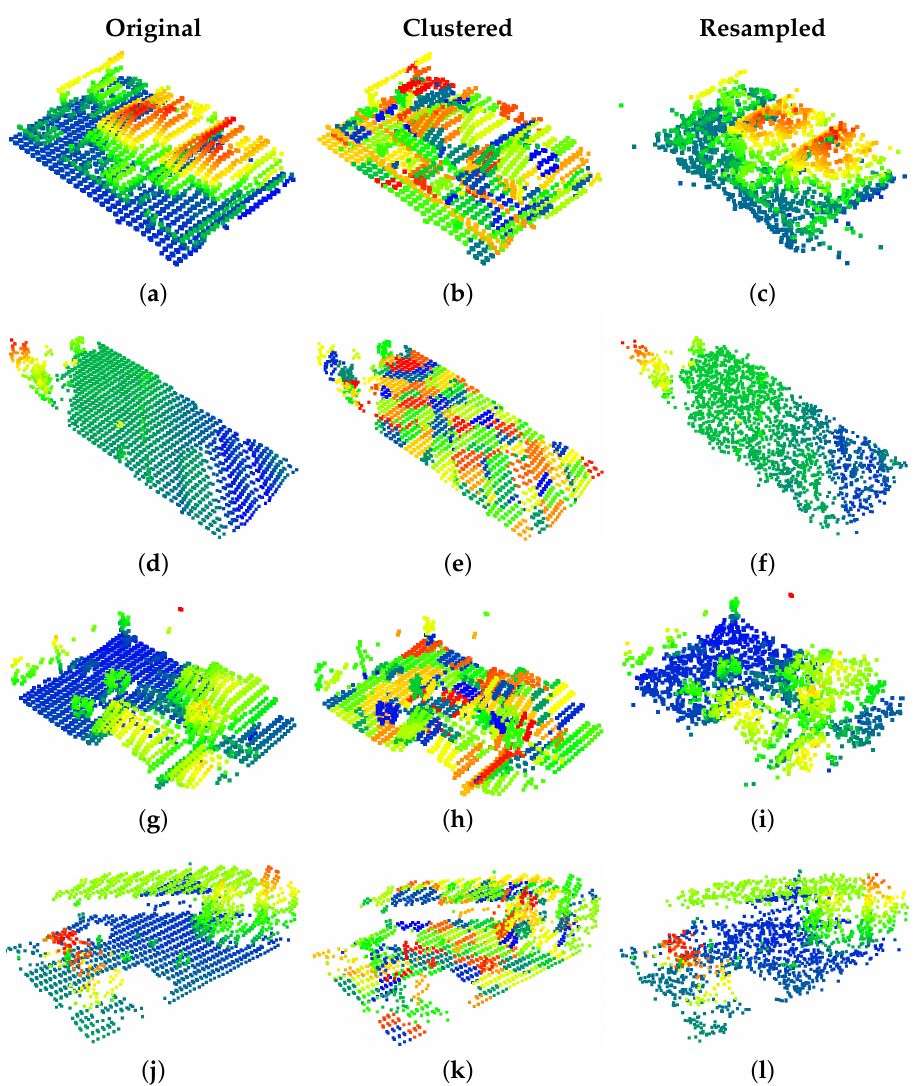
Figure 8. Example of DALES Viewpoints scenes processed with a Gaussian mixture model. The left- hand side is the original scene colored by height. The middle column shows the scene clusters, colored with a random RGB combination for each unique cluster. Finally, the right-hand side shows the resampled scenes, colored by height. These scenes have 100 components